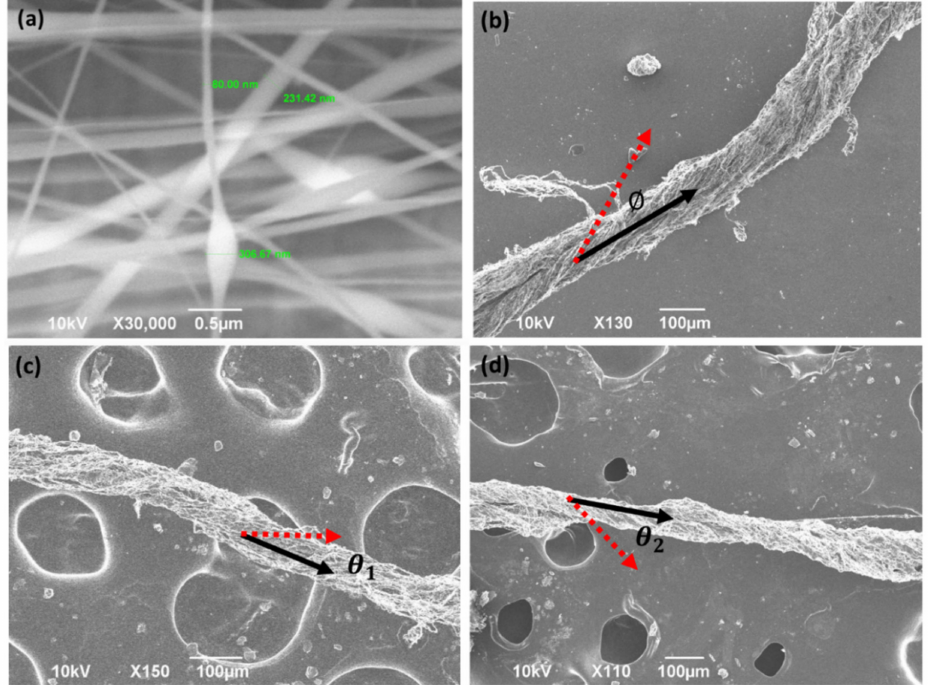
Figure 4. SEM pictures of the PEDOT/PVA structure ( a ) without treatment ( b ) with treatment obtained from the electrostatic fabrication method. ( Ø = 31 ◦ ) ( c ) Nanoyarn Material B [see Table 1] after electrospinning for 10 min. ( θ 1 = 28 ◦ ) ( d ) Nanoyarn Material B after electrospinning for 20 min. ( θ 1 = 38 ◦